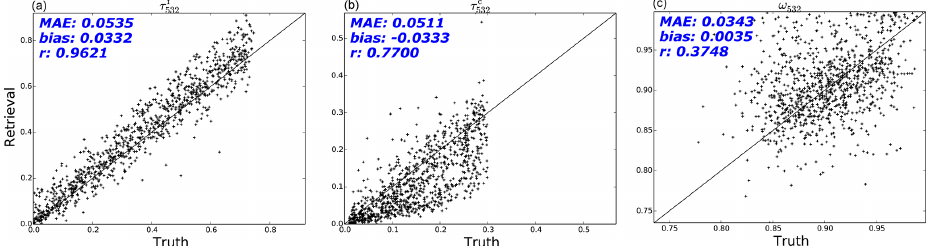
Figure 2. Retrieved optical properties versus the truth values at 532nm for the HSRL-2 setup with noise. (a) AOD of the fine mode, (b) AOD of the coarse mode, and (c) single-scattering albedo for the full aerosol distribution. Appended to the top left of each plot are the following numbers: the mean absolute error, the average bias, and the correlation coefficient. A positive bias indicates an average overestimation of the particular aerosol microphysical property, and a negative bias denotes that the parameter has been underestimated on average.